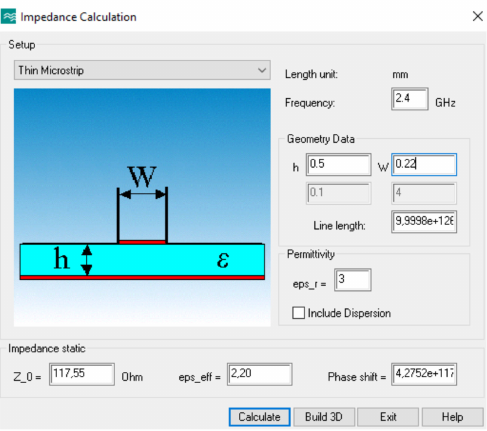
Figure 9. Calculation of the width of the transmission line (Wla) knowing the antenna